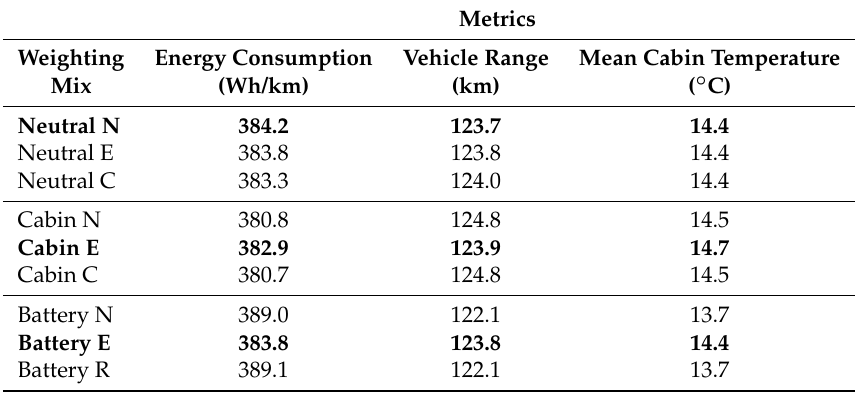
Figure 18. Heat delivered to the cabin in the first 60 s of the drive cycle at − 15 ◦ C and 0 ◦ C both using the full battery heating strategy. Table 10. Vehicle metrics corresponding to solutions from sensitivity testing performed at 0 ◦ C. Here bold text indicates the most preferable outcome in the authors